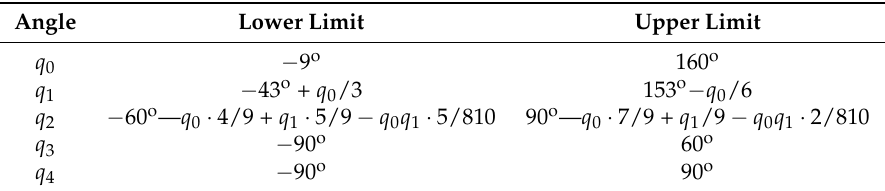
Table 2. Joint limits of the robotic